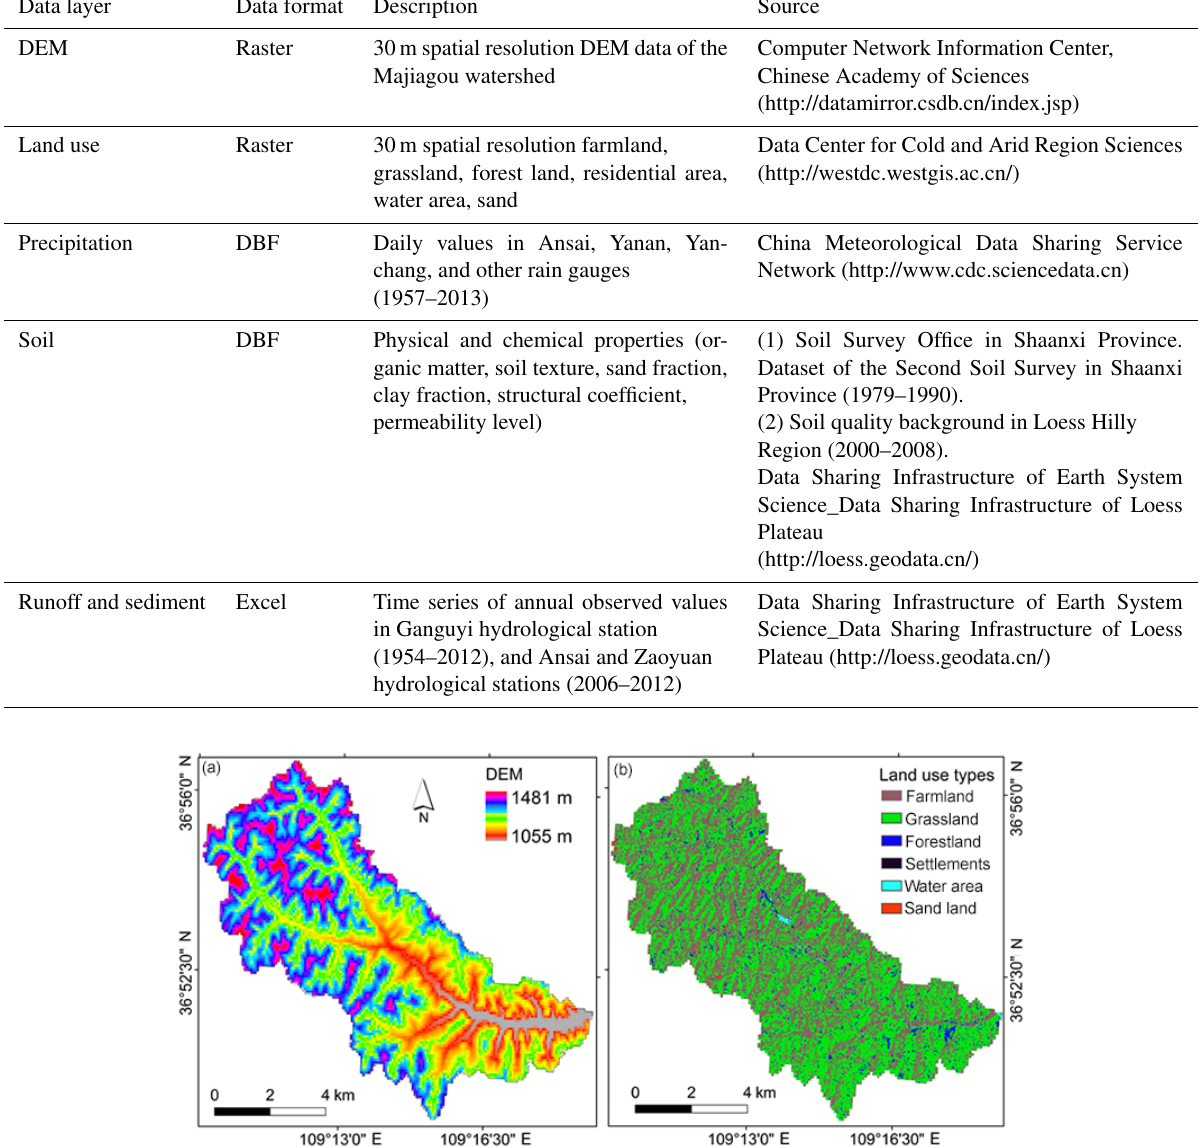
Figure 2. (a) Elevation map of the study area; (b) land use types of the Majiagon River